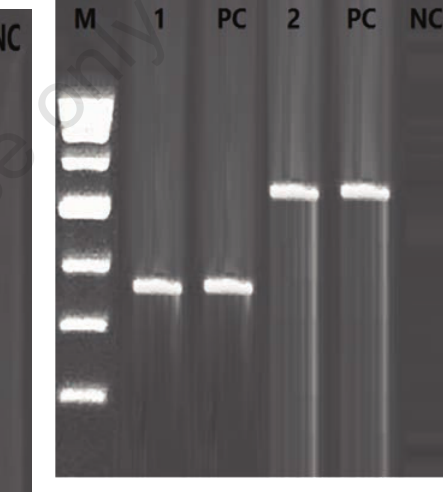
Figure 2. Results of the gel electrophoresis for virulence factors. M: 100 bp ladder, 1: Positive sample for stx2 gene (282 bp), 2: Positive sample for ehly gene (432 bp), PC: Positive controls and NC: Negative con-